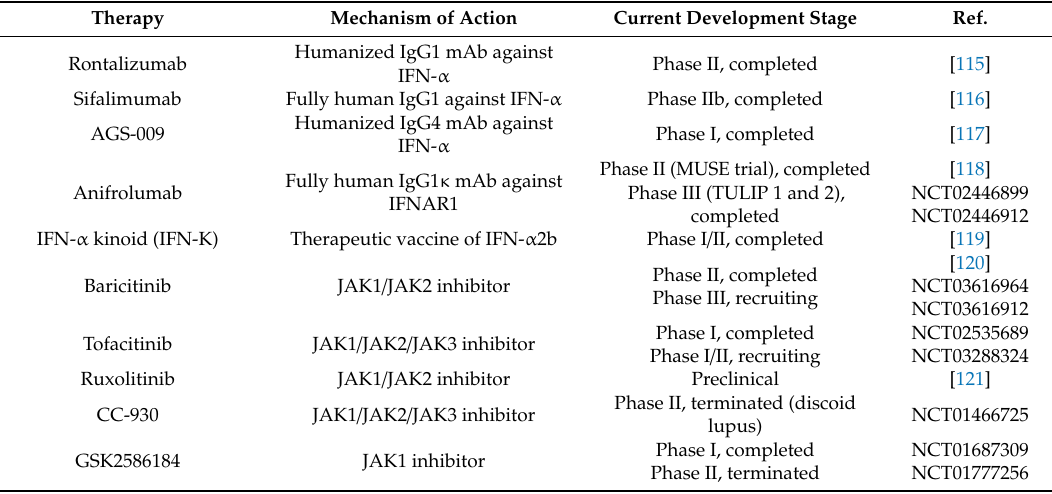
Table 1. Therapies targeting type I interferons (IFNs) and IFN signaling pathways in systemic lupus erythematosus